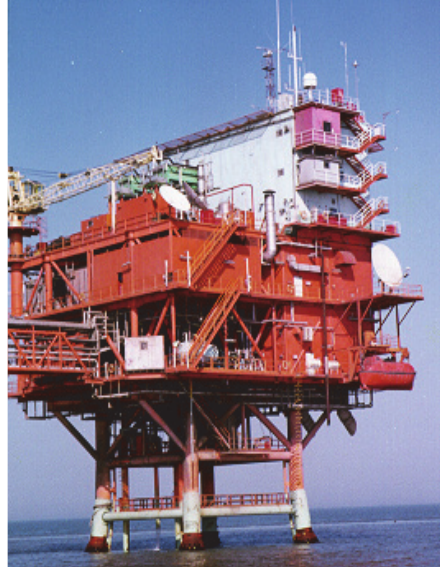
Figure 1: Photo of JZ20-2MUQ.